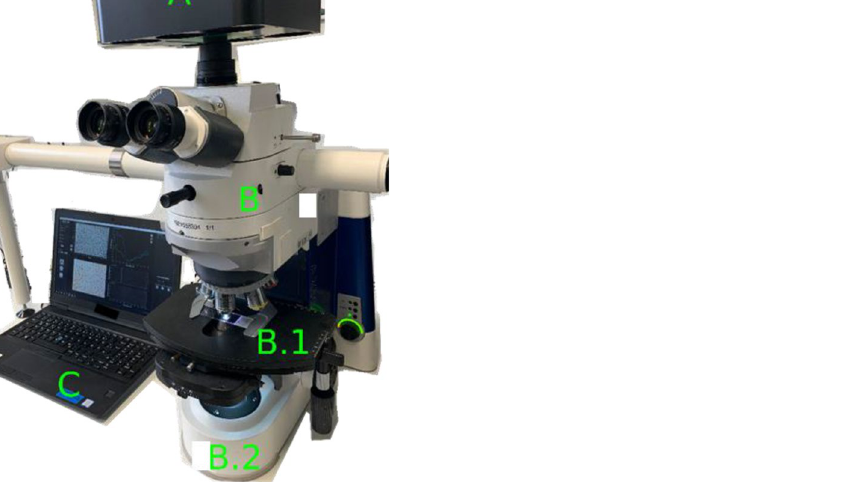
Figure 7. Experimental setup. The HSI camera ( A ) was fixed via a c-mount to a standard optical microscope ( B ). A halogen lamp (HAL100) was used (B.2) and stained slides were fixed to the specimen stage (B.1). A 20 × objective was used. HSI data were processed by a laptop computer ( C ).